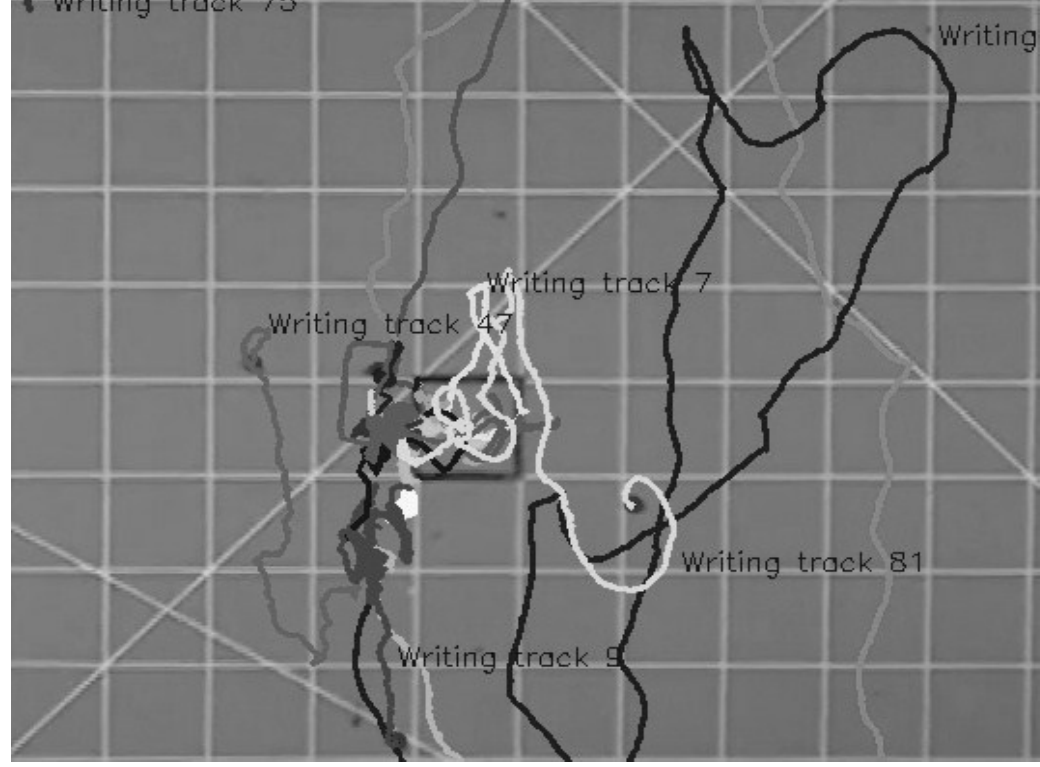
Figure 5. Bed bug movements as measured by time-lapse photography. Approximately 25% of bed bugs in the two-dimensional arena (fed or unfed) did not move more than 4 cm from the release point (For example, the white